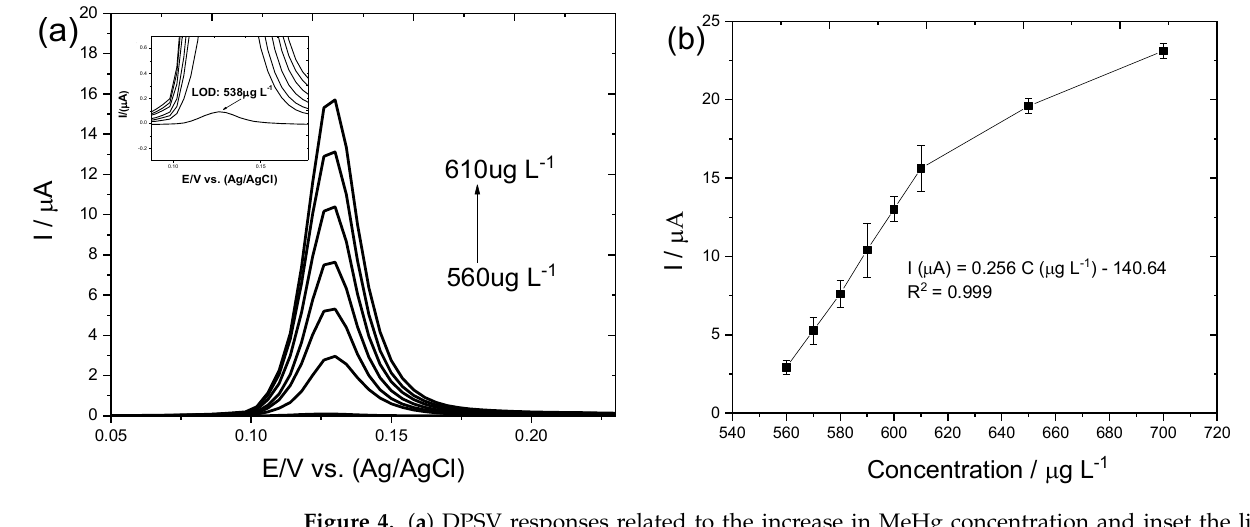
Figure 4. ( a ) DPSV responses related to the increase in MeHg concentration and inset the limit detection figure; ( b ) Calibration plot for methylmercury determination at 50 V/s. The amounts of MeHg concentration determined were 560, 570, 580, 590, 600, and 610 µ g L − 1 . Each point was an averaged value of three peak currents obtained from background-subtracted voltammograms. Table 1. Summary of previous electrochemical sensors used for methylmercury determination.